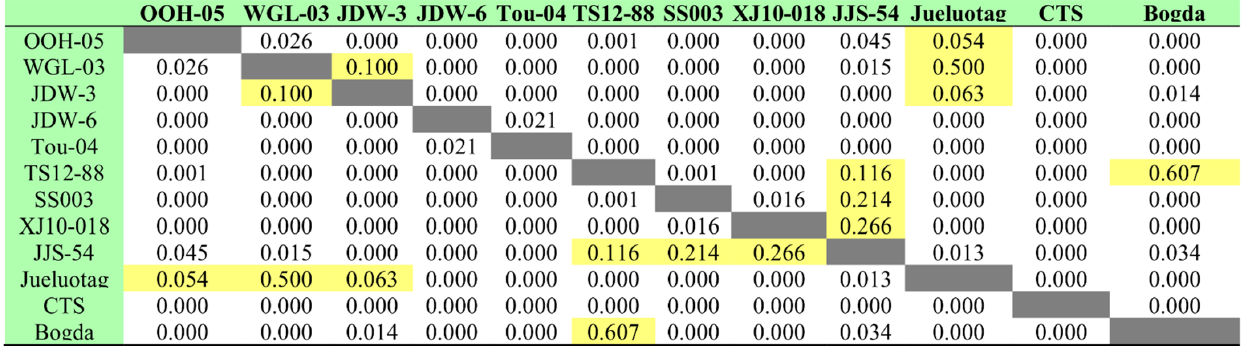
Figure 9. KS p -value tests for Middle Jurassic samples (same derived data as those in Figure 8; 95% confidence that the two groups were not statistically different; p -values had to exceed 0.05; comparisons between units with p -values greater than 0.05 are highlighted in yellow).